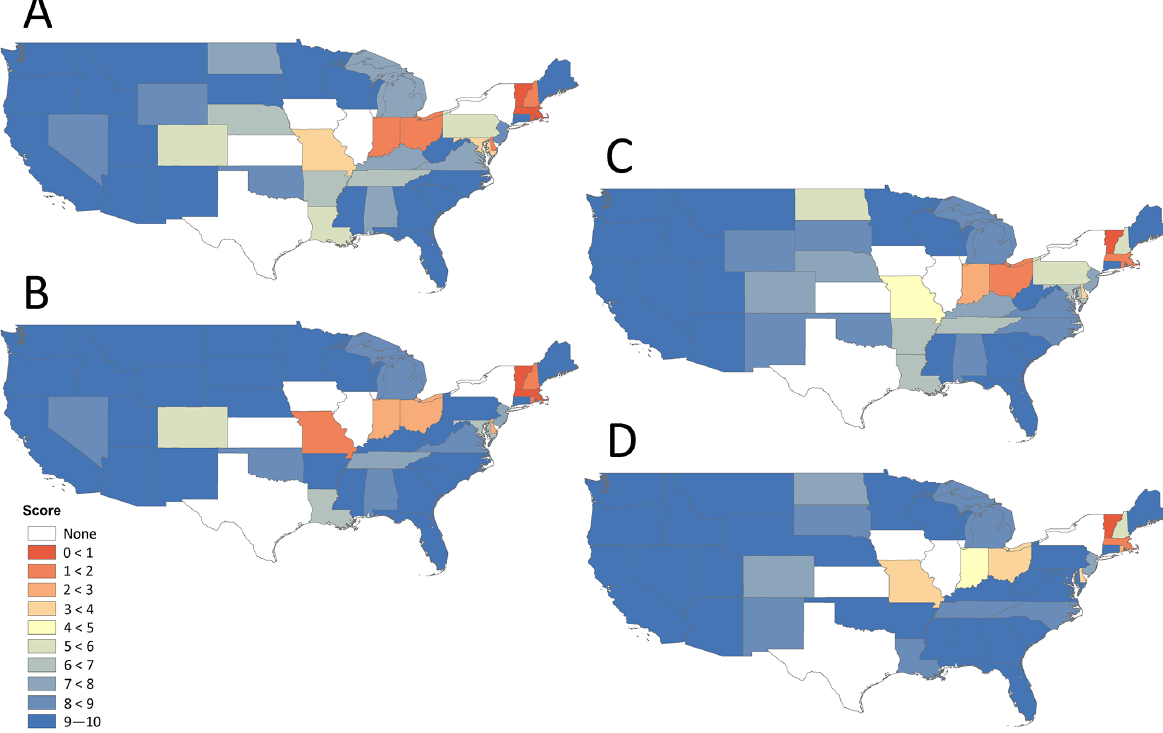
Figure 5. Maps showing agreement scores for the conterminous US for (A) wildfire numbers, 1992–2011, (B) wildfire numbers, 2002–2011, (C) wildfire area burned, 1992–2011, and (D) wildfire area burned 2002–2011 (see Tables 9 and 10). Low scores indicate states for which the FPA FOD appears relatively incomplete for the period of assessment based on national published estimates of wildfire numbers (A, B) or area burned (C, D) , while high scores indicate states for which the FPA FOD yields estimates of those metrics that tend to meet or exceed those from the reference source(s). Scores for IA, IL, KS, NY, and TX are omitted because they are misleading due to reporting biases evident in the FPA FOD and the reference sources (see Figs. 7–10).